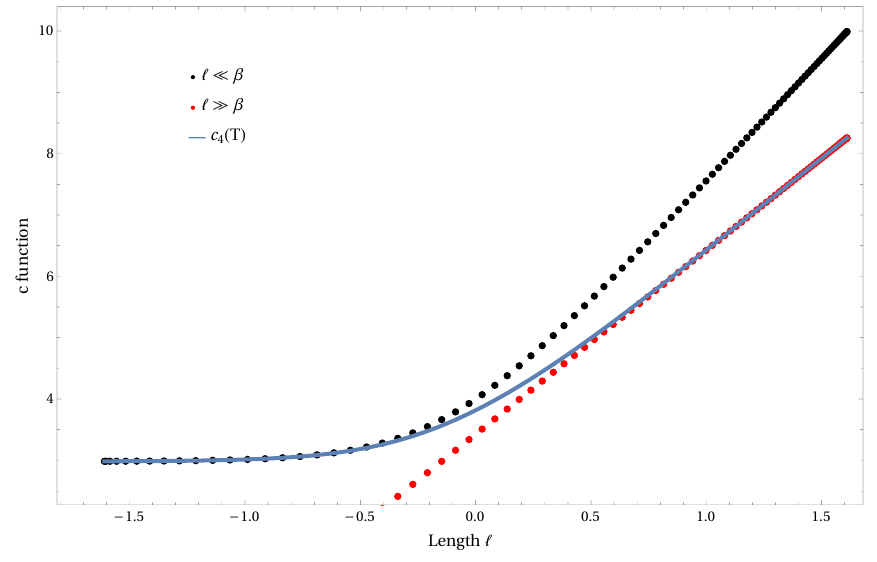
Figure 12 . Four-dimensional entropic c-function. The exact entropic c-function for N = 4 SYM theory in a thermal state is shown (blue solid curve) along with the low temperature (black dotted curve) and the high temperature (red dotted curve) limits given in eq.